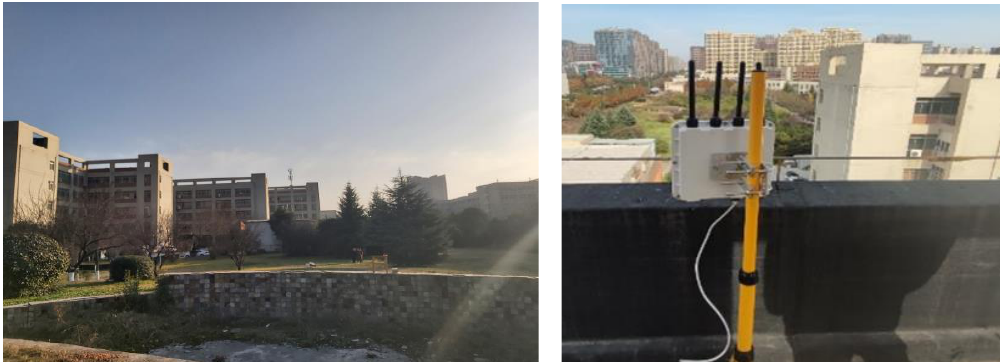
Figure 16. ED and gateway deployment locations. Table 7. Muti-Eds ’ initial parameter configuration.